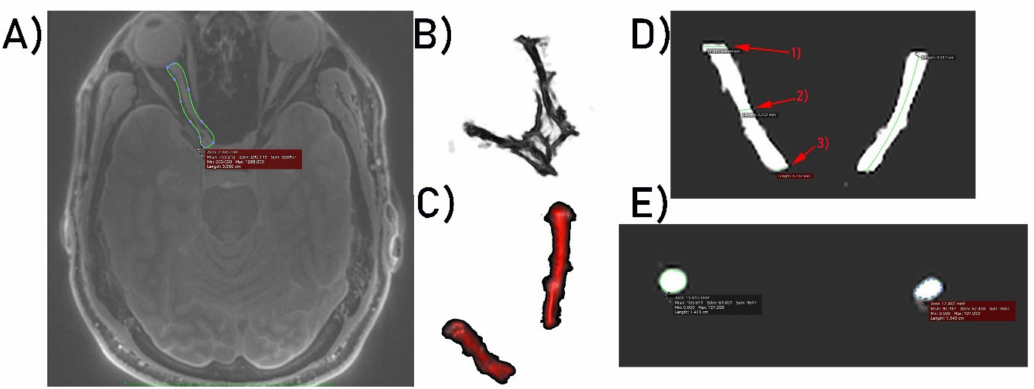
Figure 1. ( A ) Optic nerve segmentation area. ( B ) 3D model of both optic nerves. ( C ) 3D optic nerves’ reconstruction after unwanted brain tissue removal. ( D ) Optic nerve dimensioning process at three selected points, respectively: (1) 1st point of interest, (2) 2nd point of interest, (3) 3rd point of interest. ( E ) Calculation of optic nerves’ surface